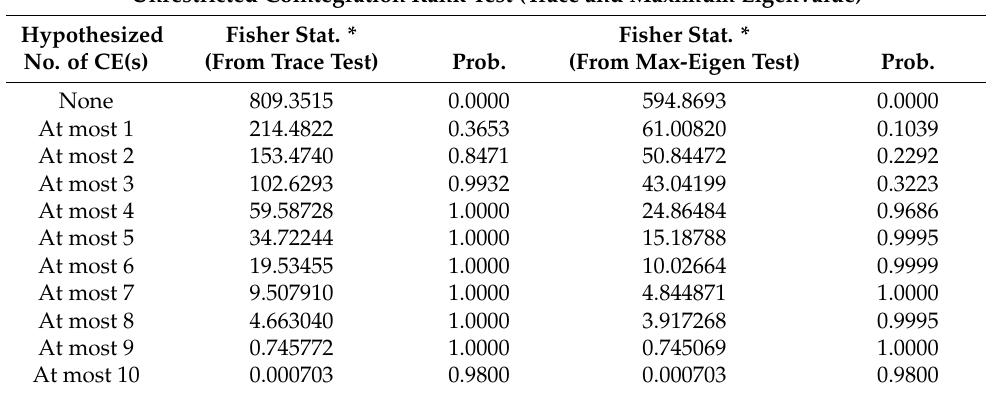
Table 6. Results for Johansen Fisher Panel Cointegration Test. Unrestricted Cointegration Rank Test (Trace and Maximum Eigenvalue)